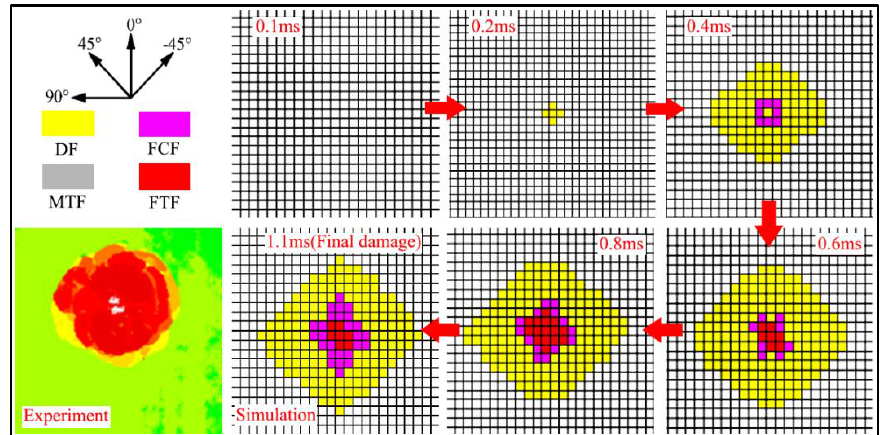
Figure 5. Progressive damage process of the laminate and the damage projection diagrams obtained by experiment [18] and simulation after the impact of 16.8 J. Note: (1) DF: delamination failure; (2) FTF: